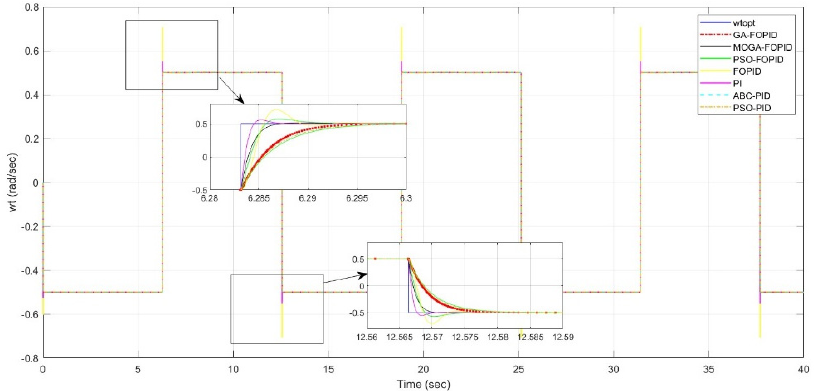
The next stage was to test the behavior of the controllers using a square wave signal with an amplitude of 0.5 and a frequency of 0.5 (rad/s). Figure 7 shows the same performance results that were obtained for the step input, both for positive and the negative slopes.